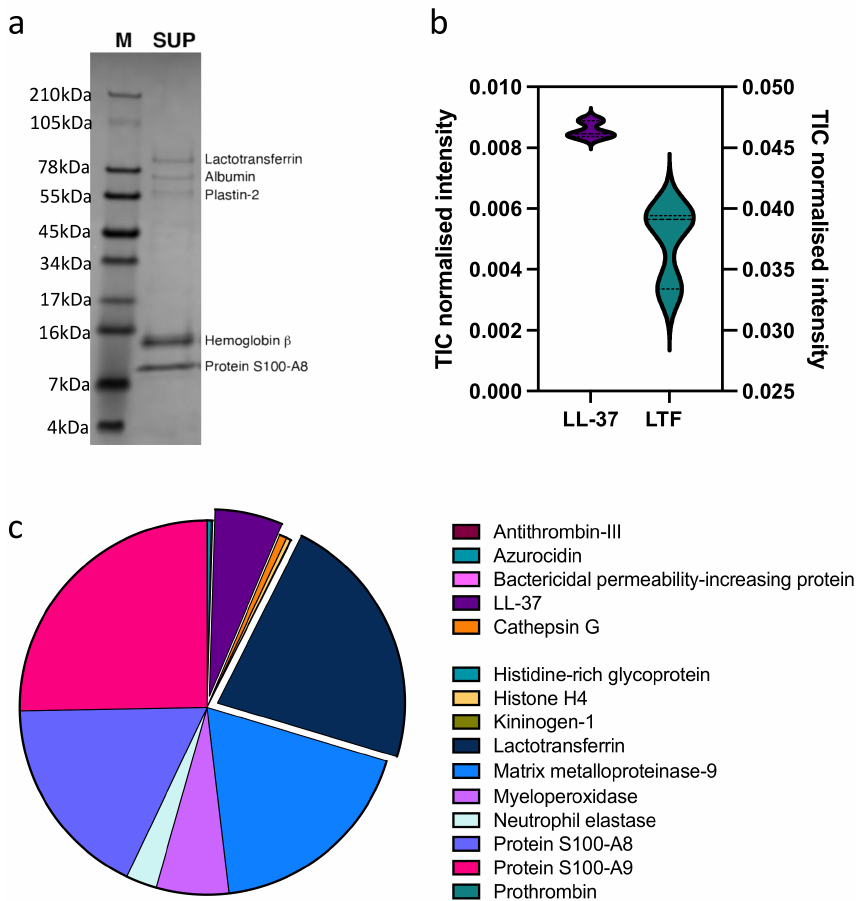
Figure 5. Quantitative MS analysis of NGC. ( a ). SDS PAGE of NGC (=SUP). The most intense gel bands correspond to 1: Lactotransferrin, 2: Albumin, 3: Plastin-2, 4: Hemoglobin β , and 5: Protein S100-A8. ( b ). Total-ion current (TIC) normalized intensity of LL-37 and LTF in NGC. ( c ). Selective representation of various HDPs found in NGC. The proteins are displayed as part of whole, and the size of each protein represents the TIC-normalized abundance. LL-37 and LTF are exploded for easier